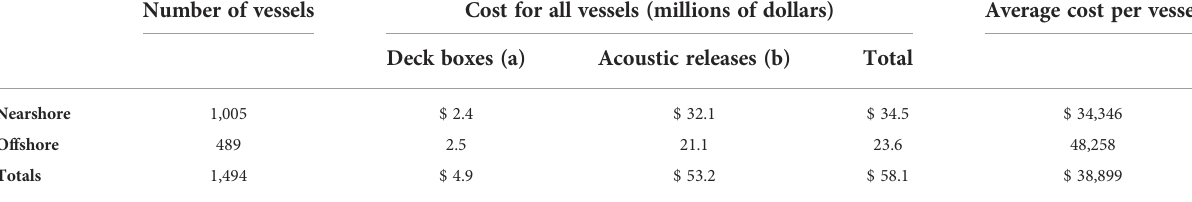
TABLE 5 Total on-demand fi shing gear adoption costs for 1,494 vessels, releases on all